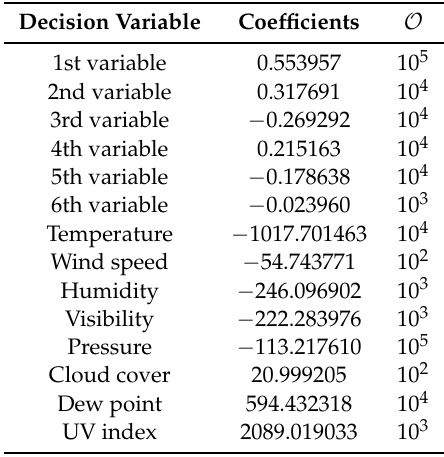
Table 3. Decision variables and respective coefficients for the model in Table